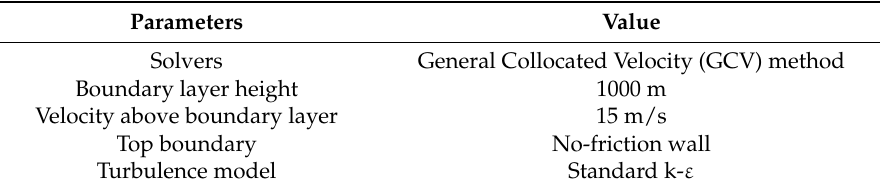
Table 2. Parameters of boundary condition adopted in present